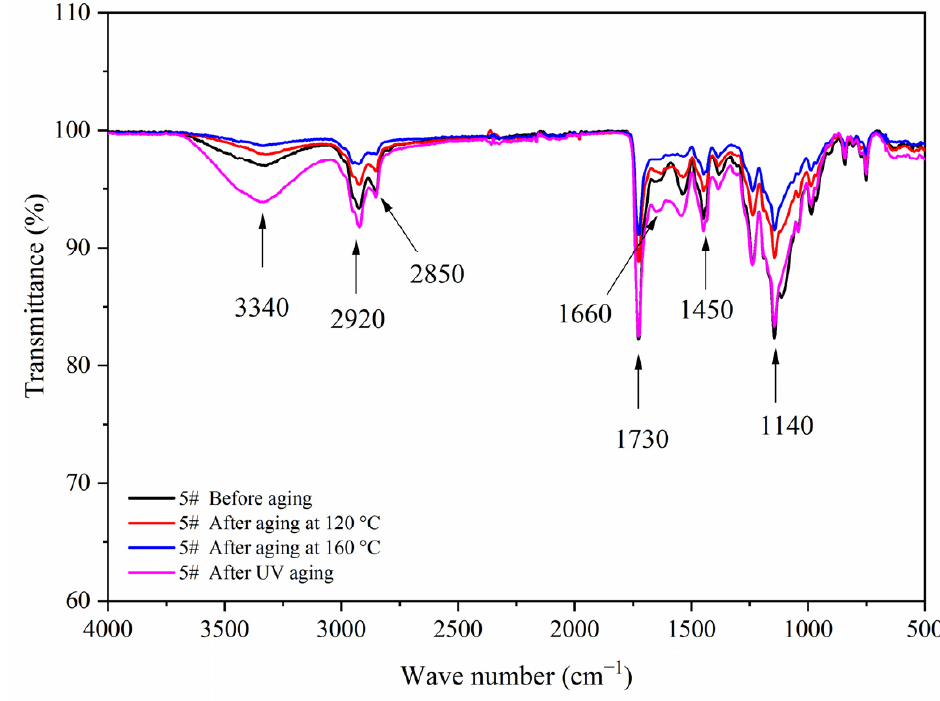
Figure 17. FTIR of sample 5# before and after aging.